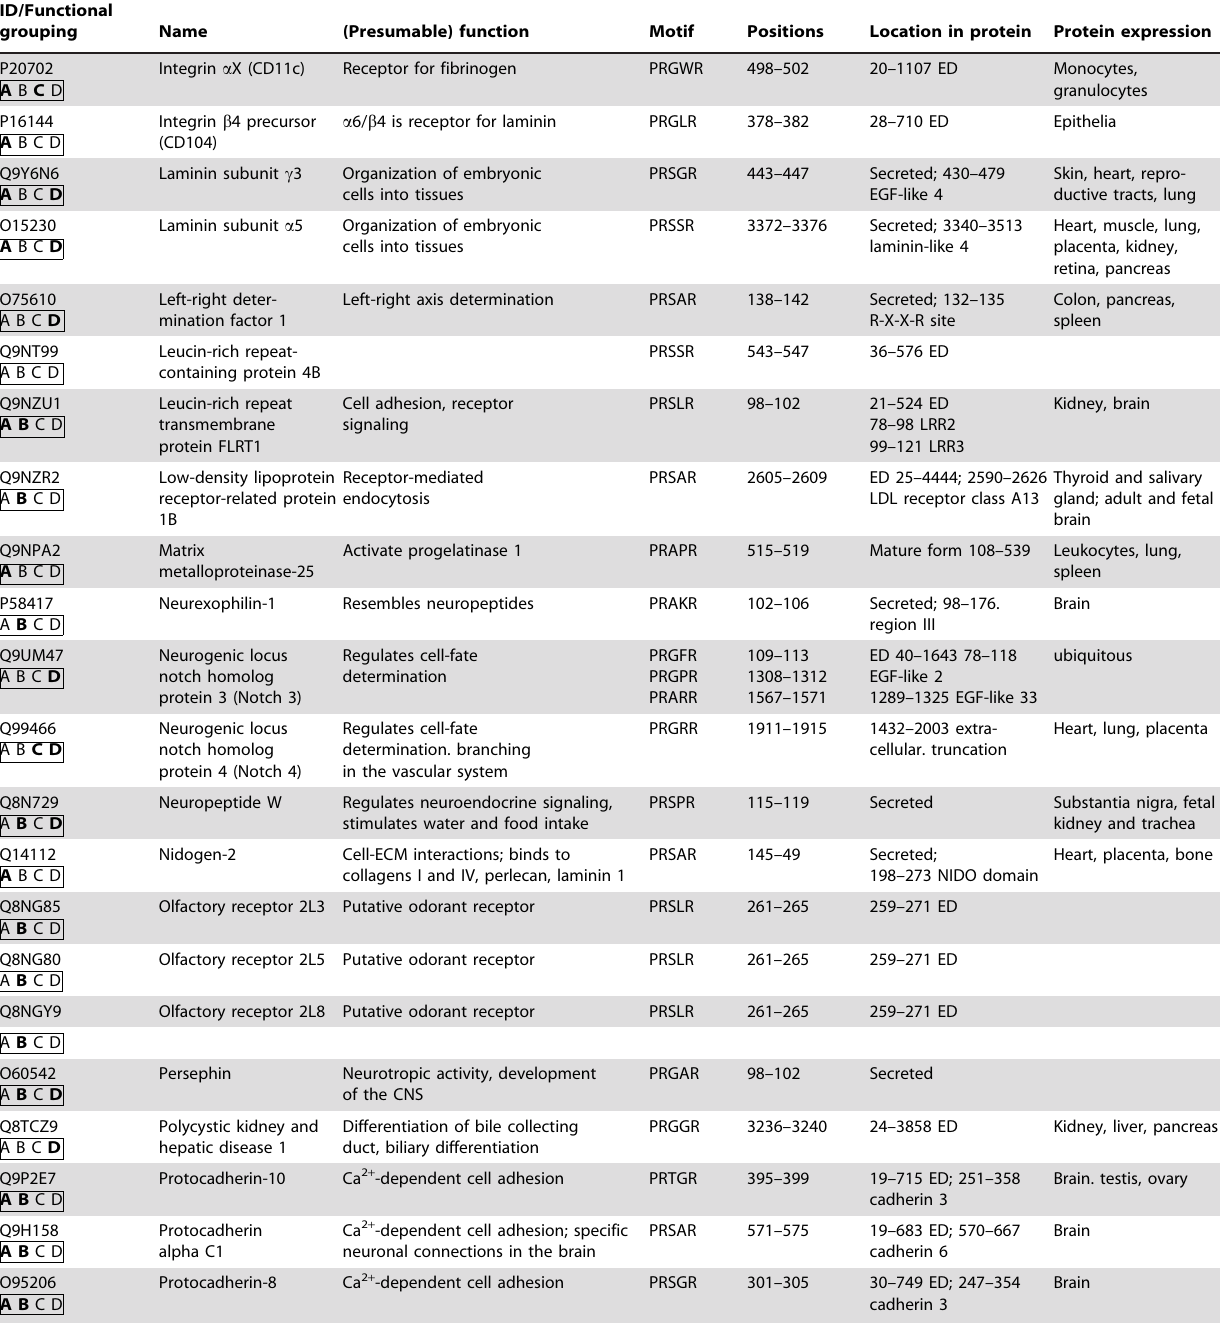
Table 5. Potential novel thrombin